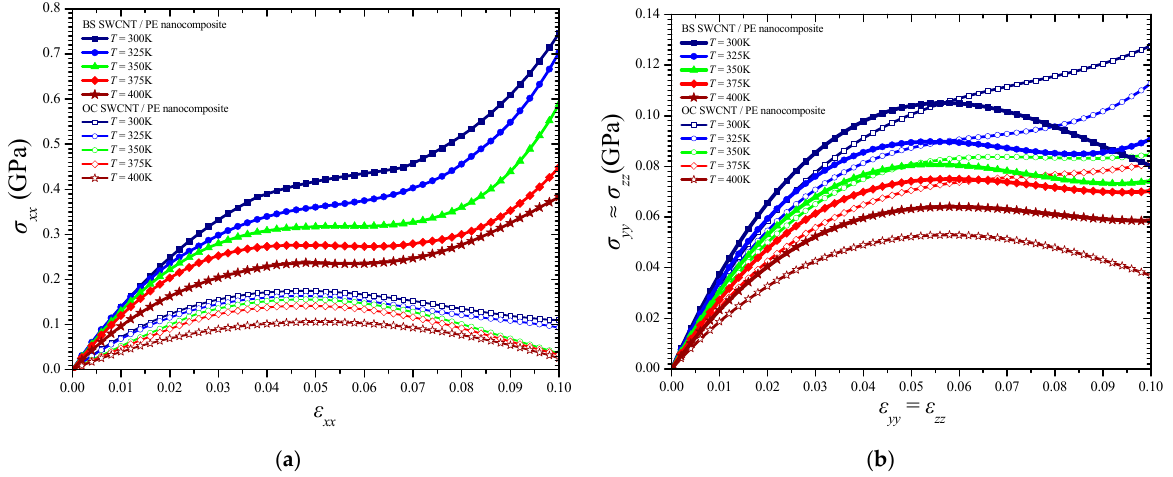
Figure 8. The tensile stress–strain curves of the simulated NCs in the ( a ) longitudinal x - and ( b ) transverse y - or z -axis for various temperatures.